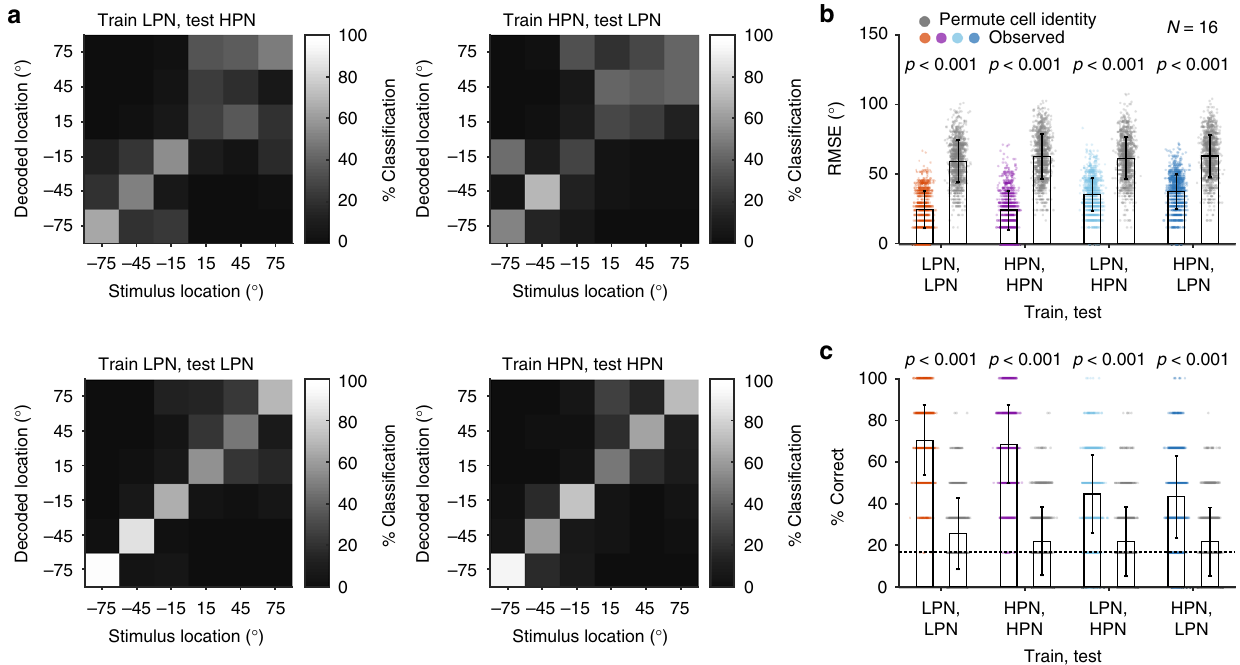
Fig. 8 Performance of the distributed model decoder across different spatial cues. a Confusion matrices showing the % of decoded location classi fi cations of each stimulus location when the distributed decoder was trained with responses to low-pass (LPN) stimuli and tested with responses to the high-pass (HPN) stimuli from the same units that had signi fi cant spatial information in at least one bin width (top left), decoder trained on HPN responses and tested on LPN responses (top right), trained and tested on LPN (lower left) and trained and tested on HPN (lower right). b Root-mean squared error (RMSE) of the decoder (coloured symbols) was lower than when the cell identities were shuf fl ed (grey) in each condition tested. The bars show the mean ± s.d. across 1000 iterations for observed and cell-identity shuf fl ed decoding. P -values indicate the probability that the difference between the observed and shuf fl ed mean RMSE is greater than the difference obtained by chance (estimated by permuting the labels between real and shuf fl ed decoder scores (1000 iterations) and calculating the difference in decoding, see Methods). c Mean± s.d. % correct of the decoder ( fi lled bars) compared with % correct when cell identity was shuf fl ed (grey bars). P- values indicate the probability that the difference between the actual and shuf fl ed mean % correct would be observed by chance. The grey dotted line indicates chance performance (1/6 chance of correct classi fi